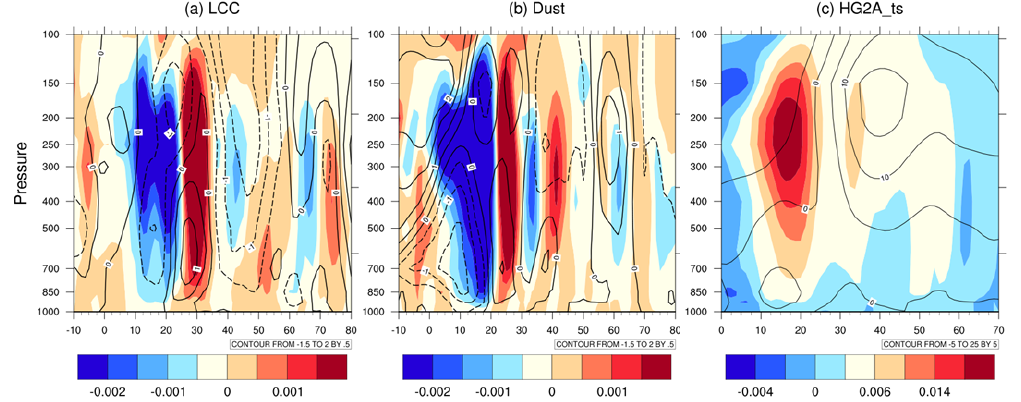
Figure 13. (a and b) Contribution to future–present changes in vertical motion (upward: red; downward: blue) and U wind anomalies (solid line: westerlies) from 110 to 120 ◦ E driven by (a) LCC impact and (b) dust impact. (c) Climatological vertical motion over 110–120 ◦ E in the HadGEM2-A time slice run (Ats).